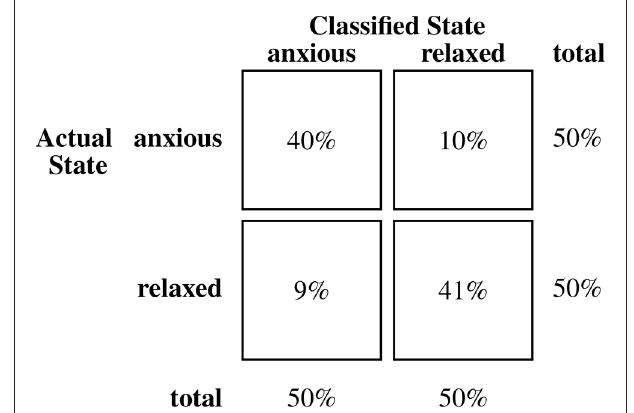
FIGURE 3 | Confusion matrix for classifications of biomusic from typically developing children (anagram) in Experiment 2.